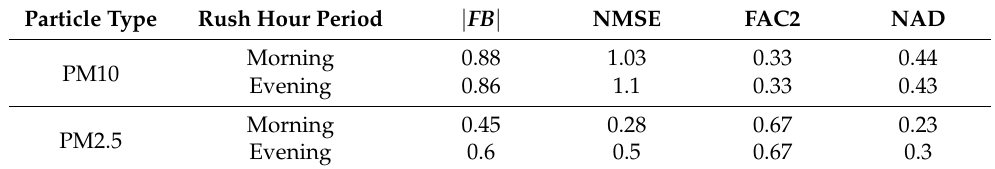
Table 1. Performance measures for the LSM estimations compared to measured PM concentrations. Particle